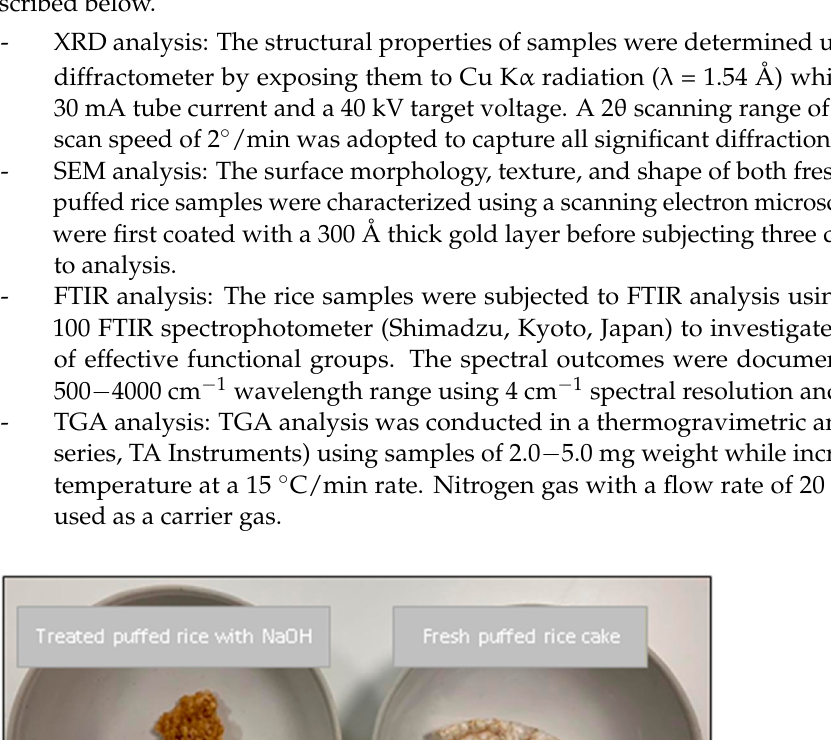
Figure 4. Fresh puffed rice sample and sample treated with sodium hydroxide.